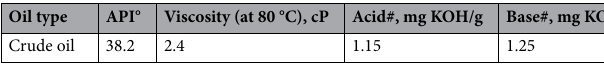
Table 3. Fluid properties of crude oil.